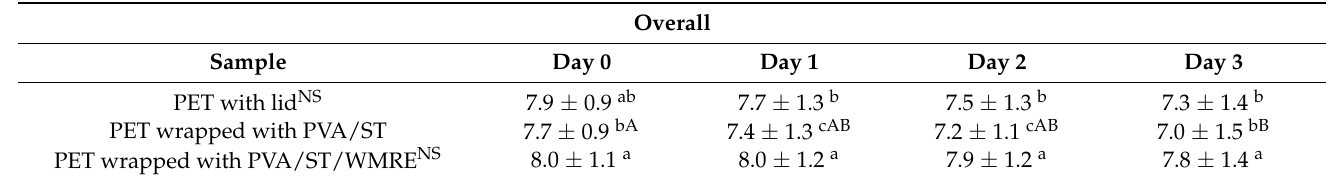
Table 7. Mean liking score and standard deviation of overall visual acceptability of fresh-cut purple cabbage (n = 50).